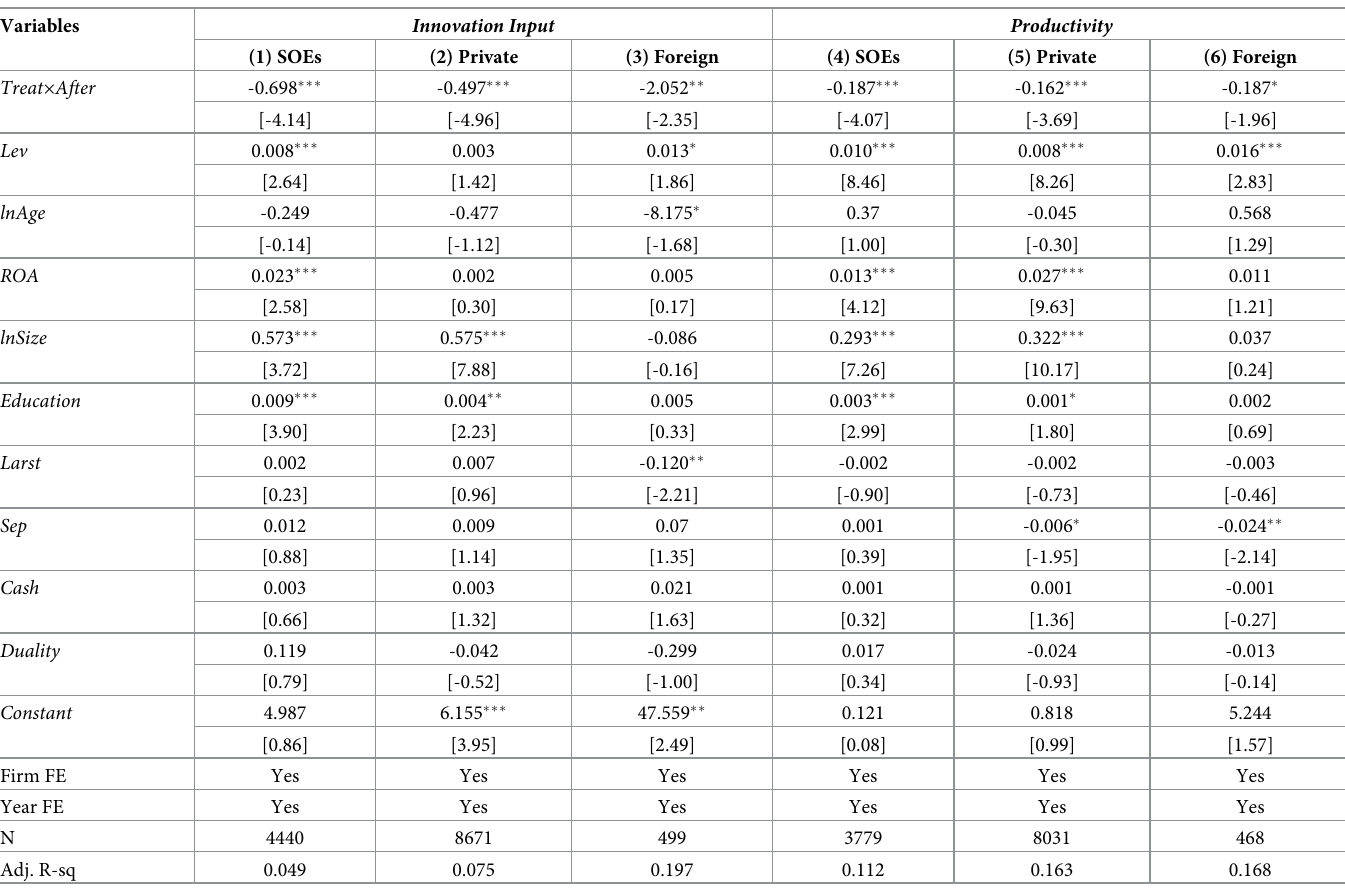
Table 7. Heterogeneous effect of EPTL2016 on firm upgrading with different